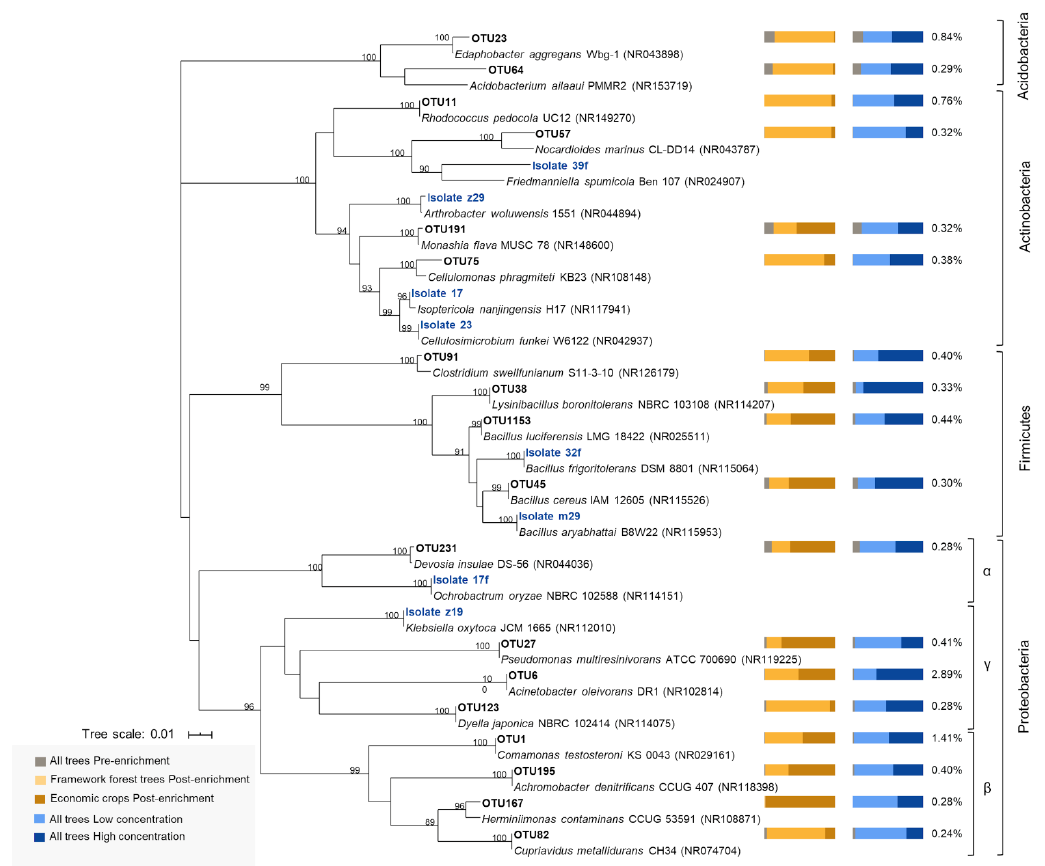
Figure 4. Neighbor-joining phylogenetic analysis of 16S rRNA genes from 18 OTUs showing an increase in abundance when grown with isoprene and eight isoprene-degrading isolates (in blue), aligned with their closest relatives. This analysis involved 402 positions, sum of branch length = 1.66. Bootstrap values greater than 80% are displayed. Bar charts on the right show the relative abundance of OTUs for the indicated treatments (pre-enrichment: soil samples before incubation with isoprene, post enrichment: soil samples after incubation with isoprene). Percentage values on the right show the mean relative abundance of OTUs in all post isoprene enrichments.